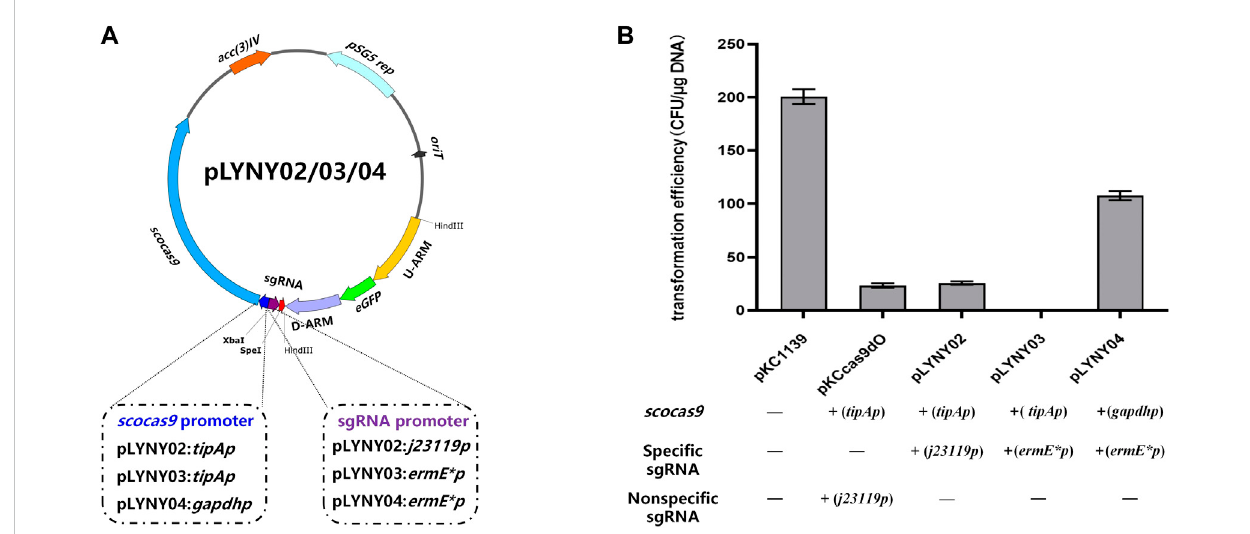
FIGURE 1 The CRISPR/Cas9-mediated editing plasmids for targeted gene editing in A. keratiniphila . (A) Schematic diagram of the editing plasmids pLYNY02, pLYNY03, and pLYNY04. Notable features included a codon-optimized scocas9 driven by tipA promoter or gapdh promoter, target-speci fi c sgRNA expression cassette driven by j23119 promoter or ermE* promoter, the homologous arms fl anking the target gene, a temperature-sensitive pSG5 origin, andselectionmarker aac(3)IV . (B) EffectsofdifferentCRISPR/Cas9-mediatededitingplasmidsonthetransformationef fi ciency.Thehighexpression of scocas9 under control of the inducible promoter tipA had toxicity and prevented the cell growth. The number of transformants was greatly decreased with pLYNY02, where no transformants were obtained with pLYNY03. When scocas9 was driven by the endogenous promoter gapdh from